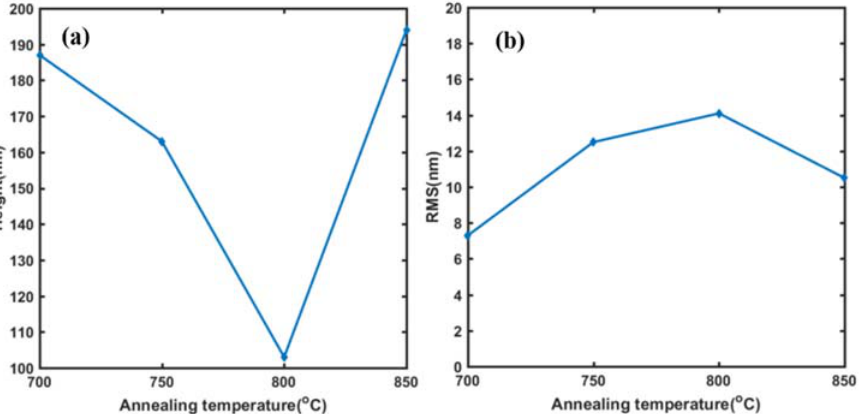
Figure 13. The step height ( a ) and the RMS ( b ) at the contact edge of the electrode and the epitaxial layer at the annealing temperature from 700 °C to 850 °C. layer at the annealing temperature from 700 ◦ C to 850 ◦